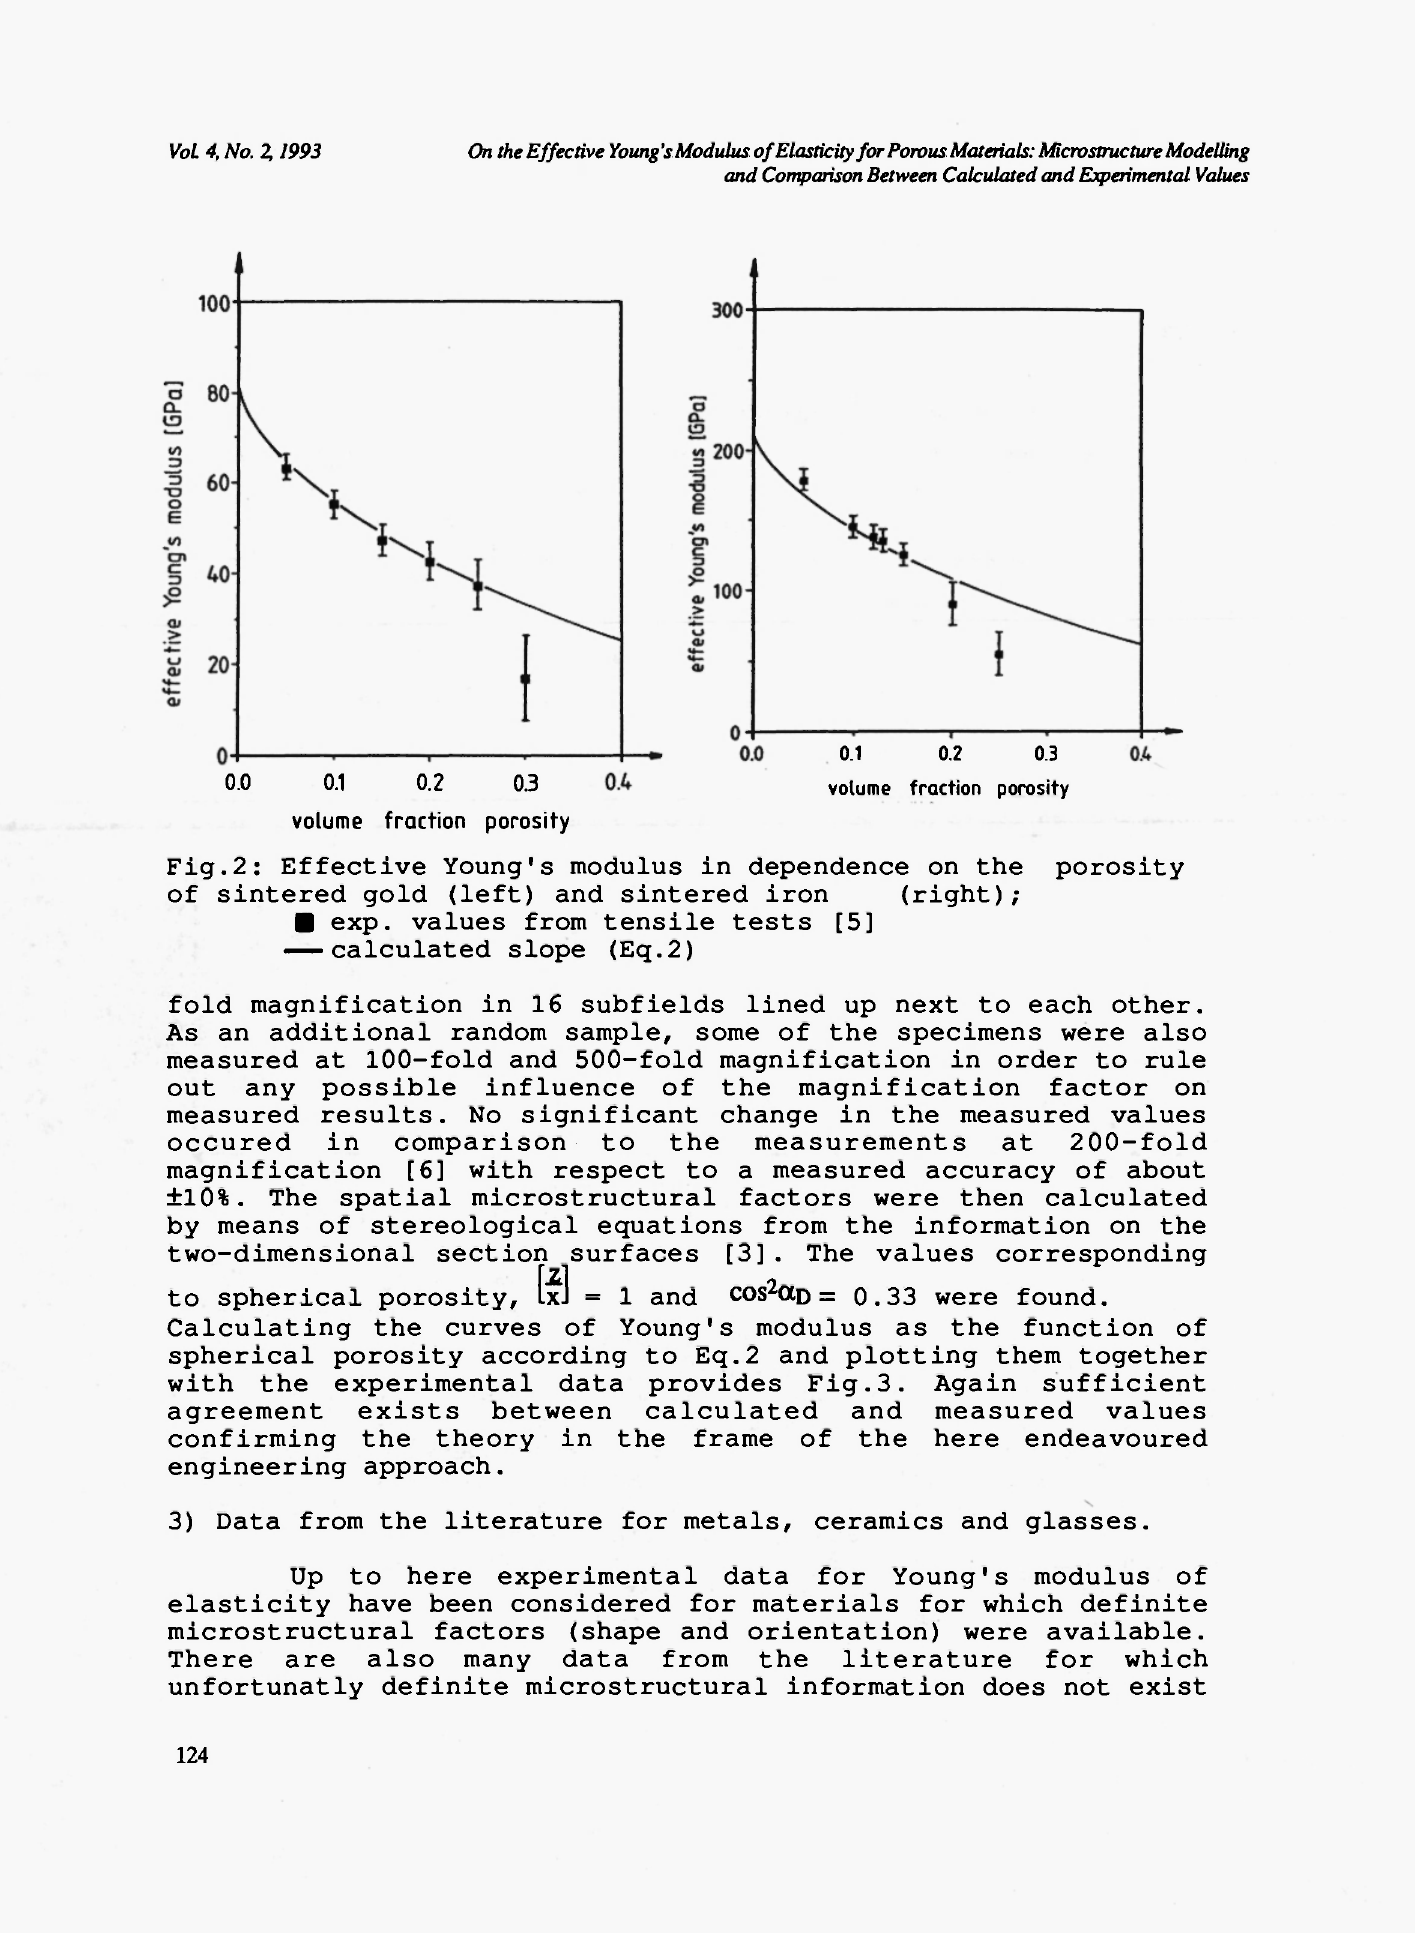
Fig.3. Again in the frame of the here endeavoured